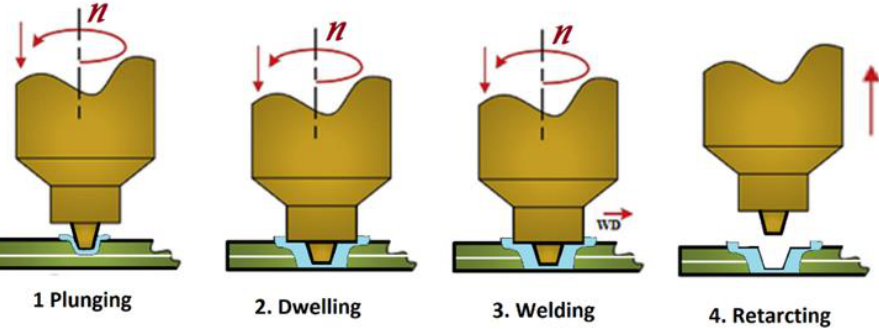
Figure 4. Stages involved in two layer joining (FSLW) (reprinted from [51] with permission from Elsevier).